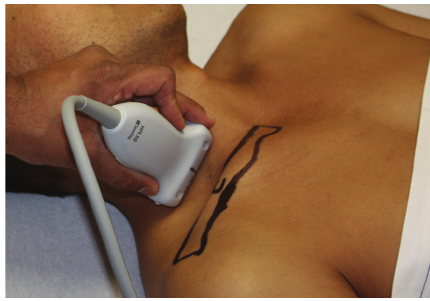
Figure 4: Transverse ultrasound image of interscalene brachial plexus. Arrowheads outline brachial plexus roots within the inter- scalene groove. SCM: sternocleidomastoid muscle, IJ: internal jugu- lar vein, CA: carotid artery, ASM: anterior scalene muscle, MSM: middle scalene muscle.